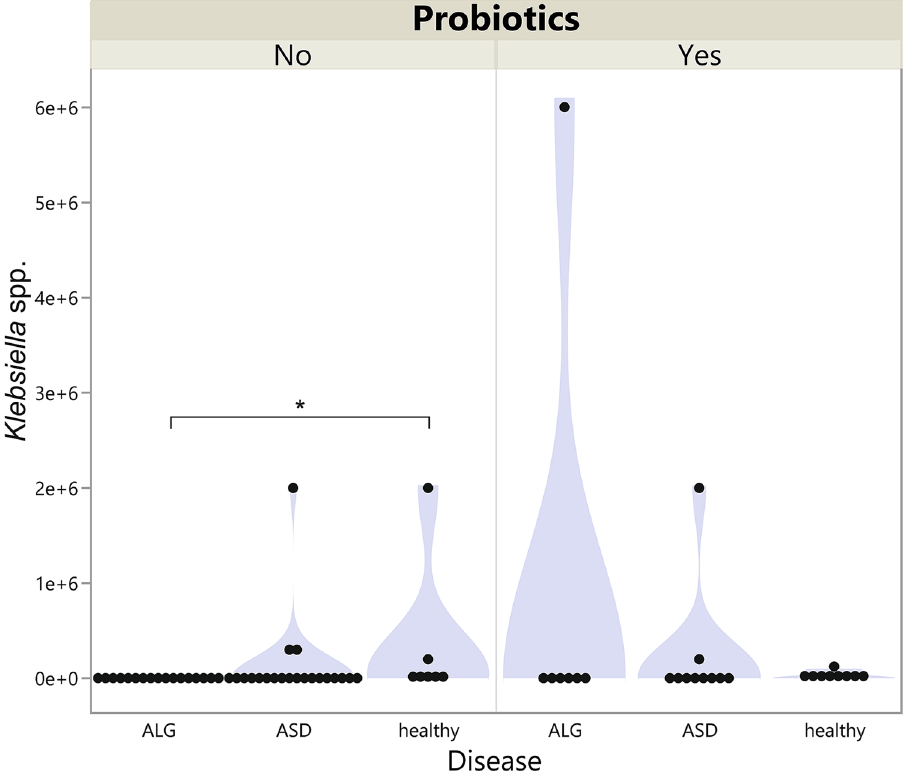
Figure 2. Violin plot of Klebsiella spp . level in the stool of children with ASD, allergies, and in the healthy group divided by probiotic usage. * p <